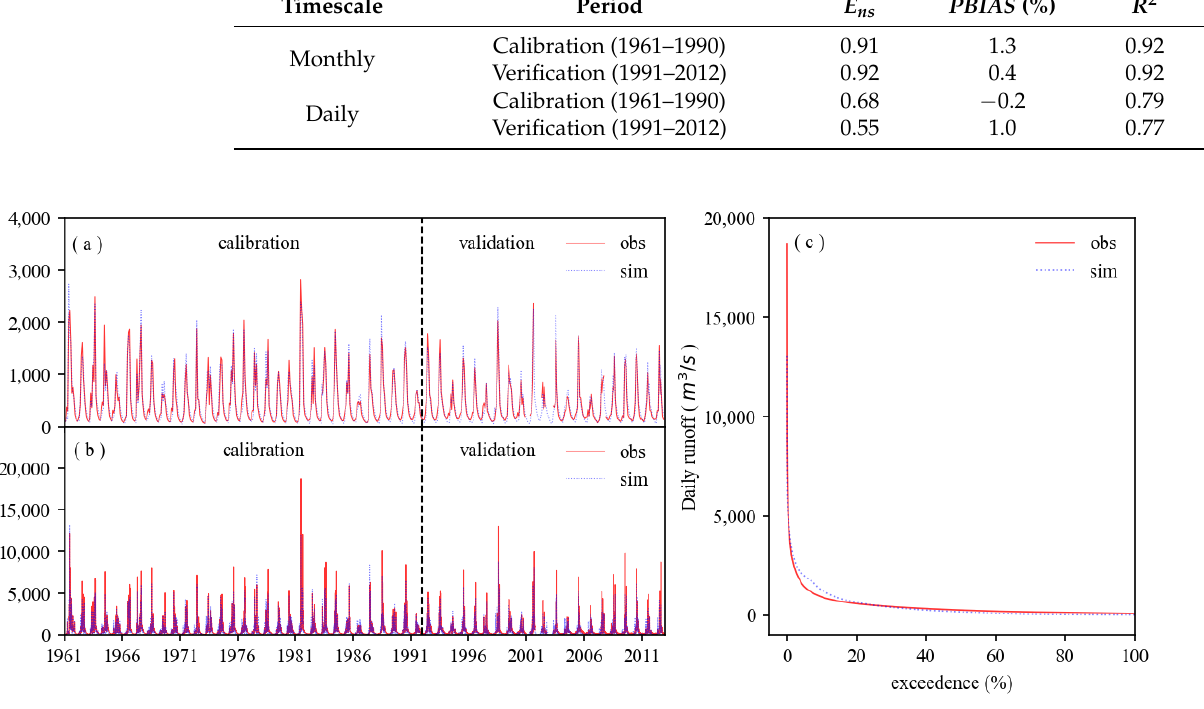
Figure 2. Comparison of observed and simulated ( a ) monthly runoff, ( b ) daily runoff, and ( c ) flow duration curve at Xiaoheba hydrological station in the Fujiang River for 1961 – 2012.